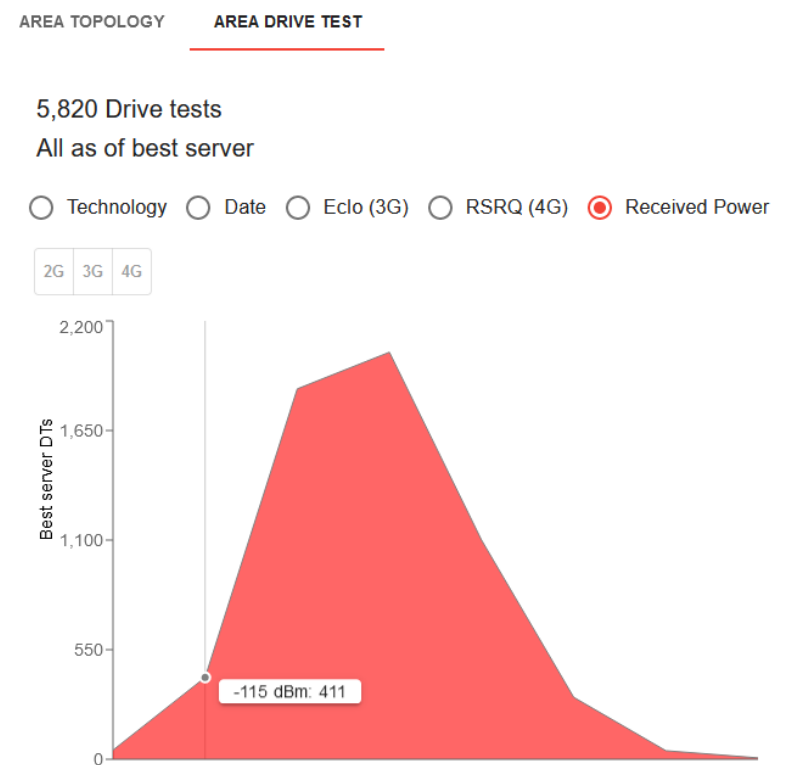
Figure 15. DTs received power distribution.